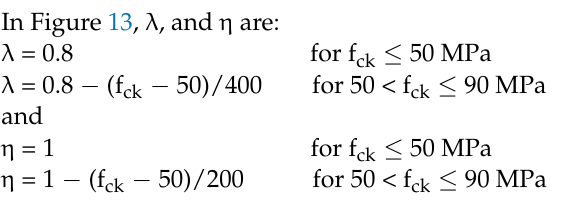
Figure 13. Strain and stress distribution in